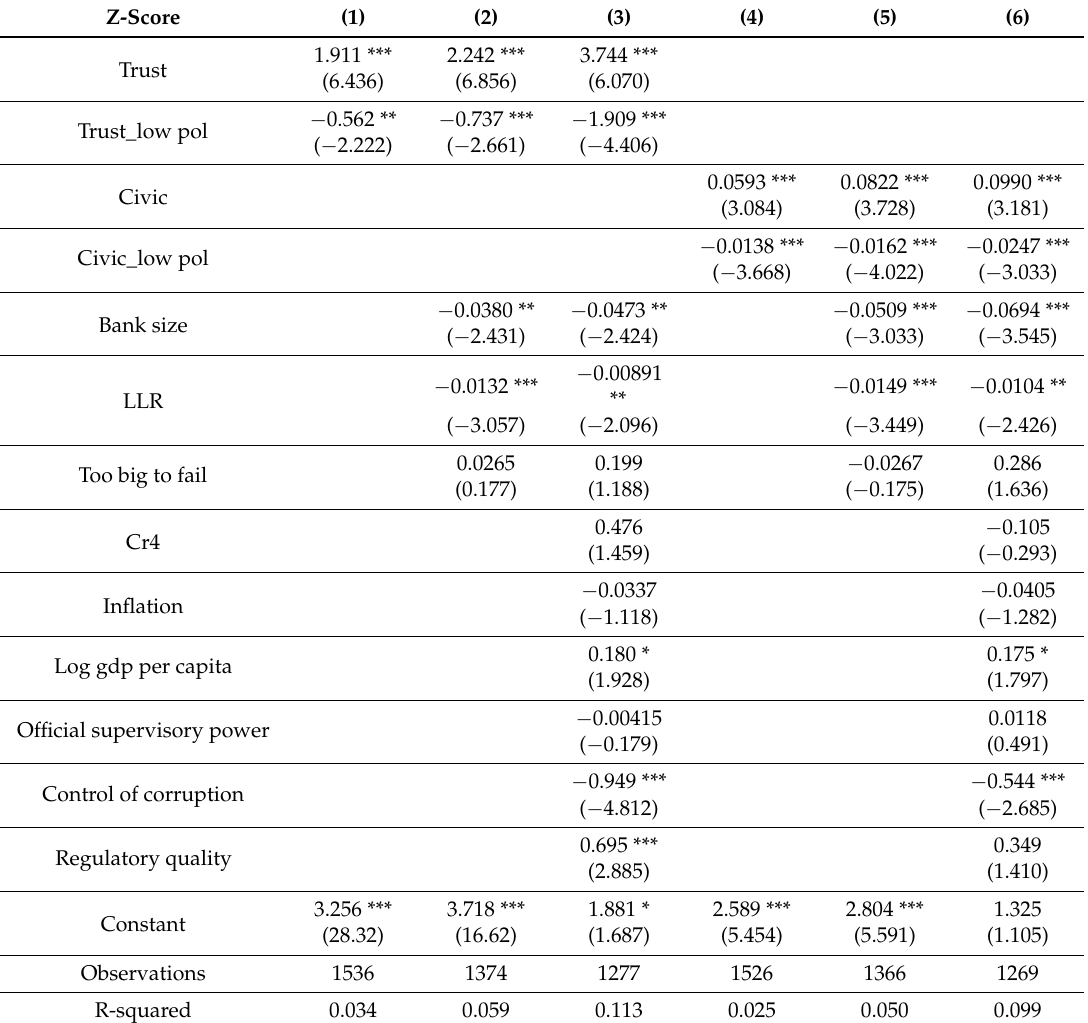
Table 8. Social capital and bank risk-taking: When political power is